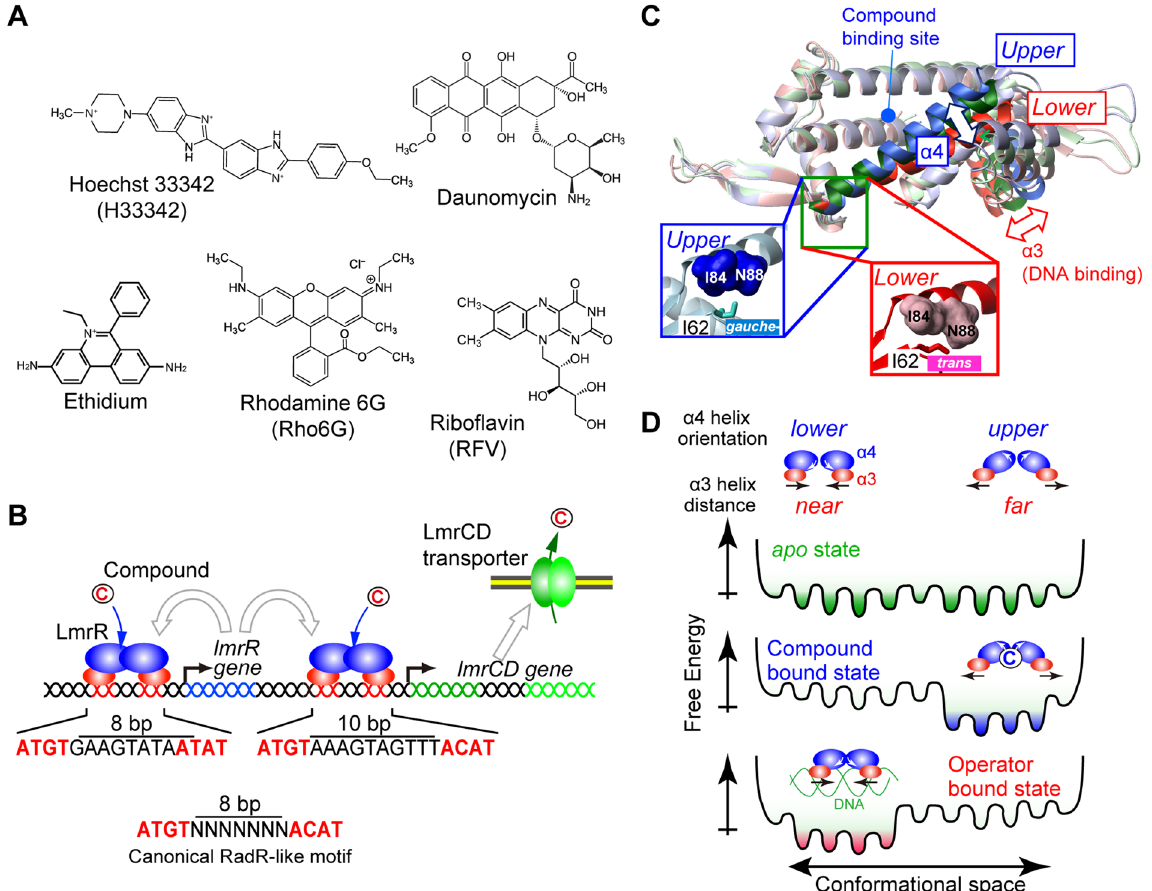
Figure 1. Ligands, regulatory mechanism, and structural properties of LmrR. ( A ) Chemical structures of compounds that are able to bind to LmrR. ( B ) Schematic representation of gene regulation by LmrR. LmrR regulates the transcription of both the lmrR and lmrCD genes by binding to their respective operator regions. White arrows indicate the destinations of proteins that are translated from each gene. ( C ) Different orientations of the C-terminal α 4 helix. A superposition of the LmrR dimer structures is shown (3F8C, blue; 3F8B, green; 3F8F, red). Inset: close-up view of the hinge region. The Ile62 χ 2 angle is defined by the α 4 helix orientation. The α 4 helix orientations are coupled to the distance between the α 3 helices. ( D ) Schematic representation of the LmrR conformational equilibrium in the apo , compound-bound, and DNA-bound states, which underlies the reciprocal compound/operator binding by